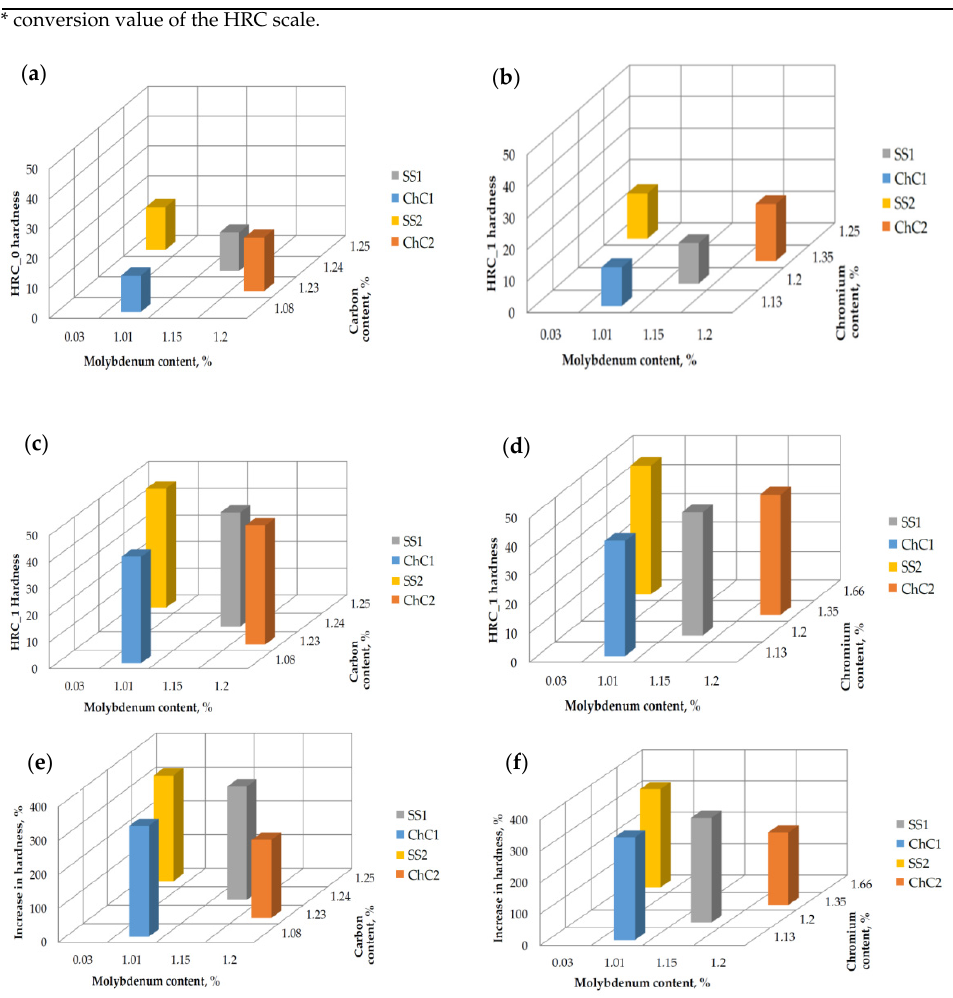
Figure 12. The relationship between the values of HRC_0 and HRC_1 and the content of carbon, chromium and molybdenum content in the particular alloys: ( a , b ) HRC_0; ( c , d ) HRC_1; ( e , f ) increase in HRC.